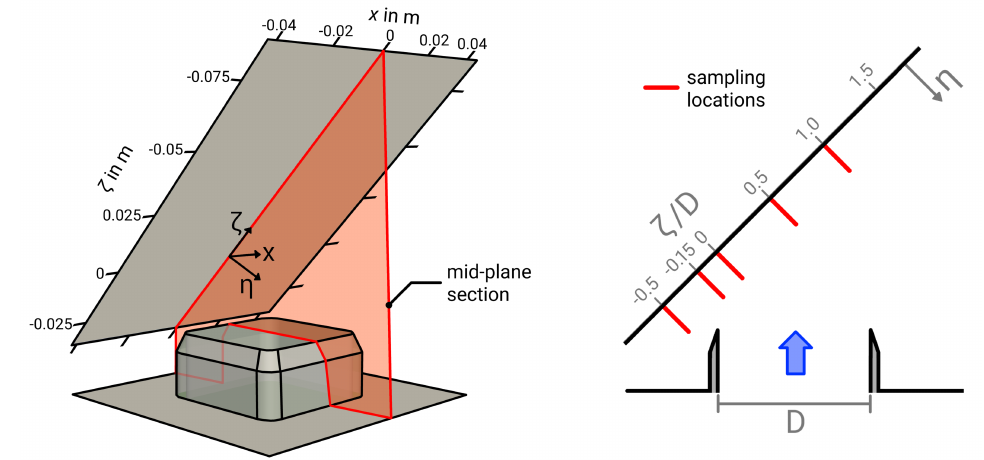
Figure 3. Coordinate system and sampling locations at ζ / D = − 0.5, − 0.15,0,0.5,1.